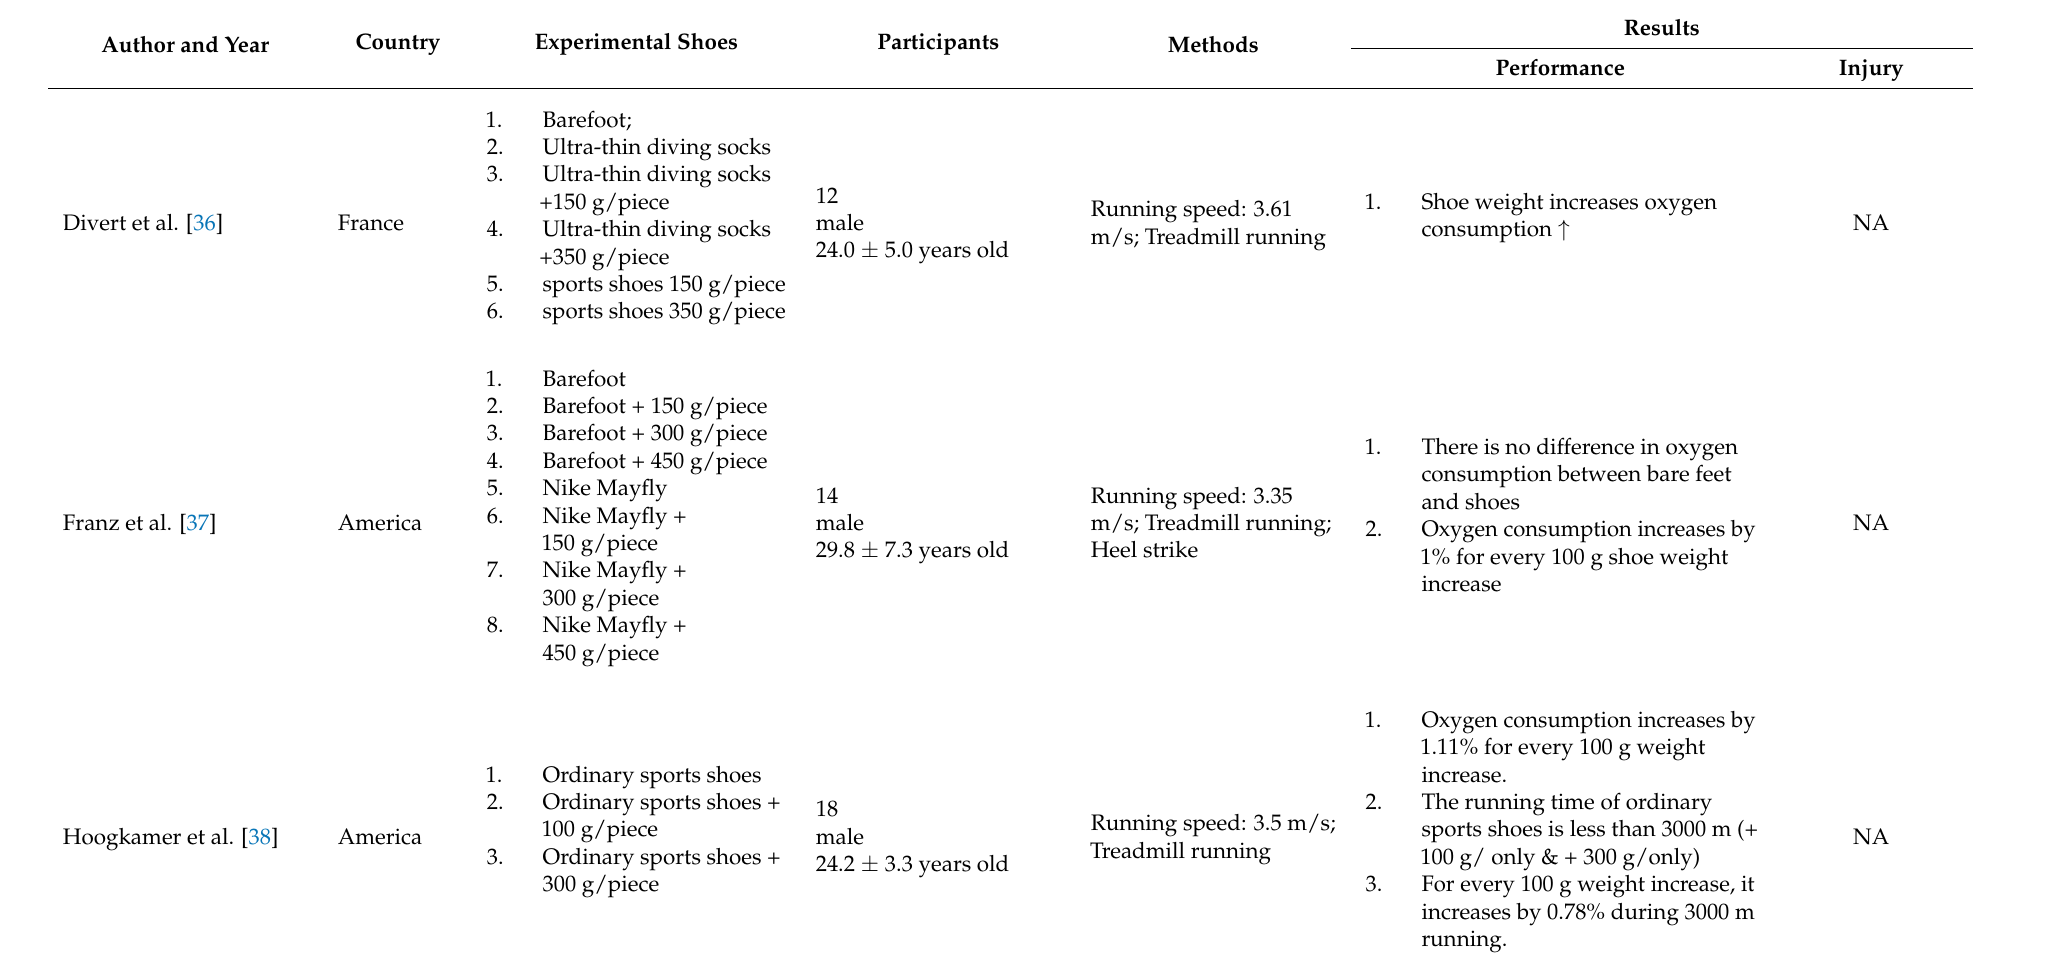
Table 4. The influence of running shoes’ weight on running performance and related